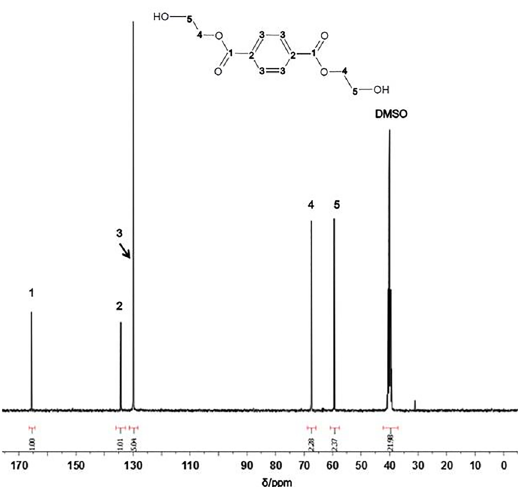
Figure 8. 13 C-NMR spectrum for BHET, the main product of PET glycolysis.